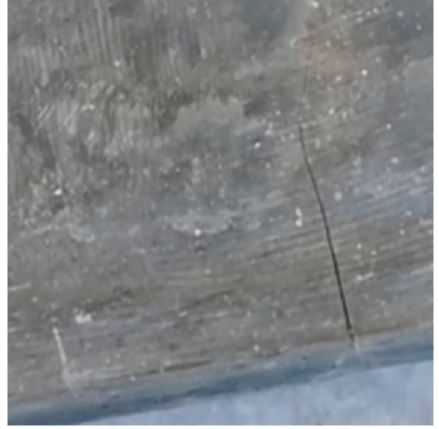
Figure 8. 30%DM ‐ 70%GGBS Pavement tile specimen image.